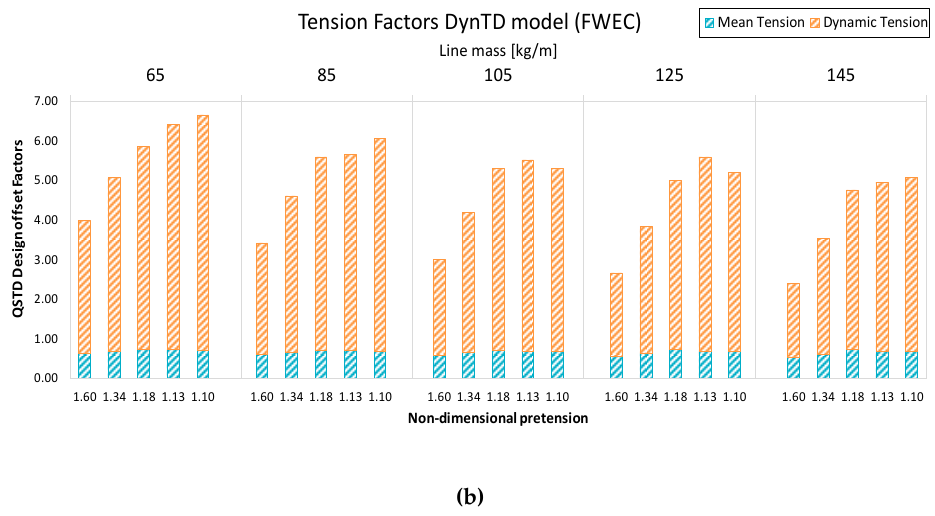
Figure 11. Most loaded line tension factors for the FWEC with the QSTD (a) and DynTD